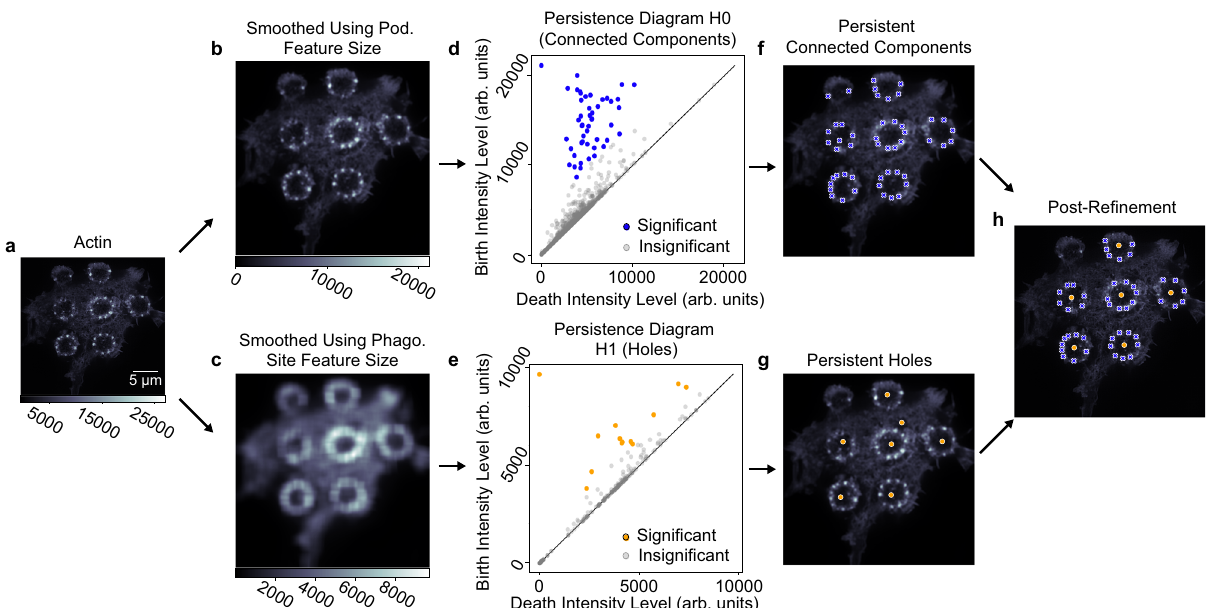
Fig. 3 | Methods for identifying podosomes and site locations. a TIRF-SIM ima- gingofactininacellwithmultiplefrustratedphagocytosissites.Colorscaleshows pixel intensity (arb. units). b , c Smoothed images of the entire cell based on the features of interest (podosomes i.e., pod. or phagocytosis sites i.e., phago.). An insigni fi cant amount of noise is added for uniqueness. Color scales show pixel intensity (arb. units). d , e Persistence diagram based on images from b and c . In d , dots (homology-0) represent connected components, and in e dots (homology-